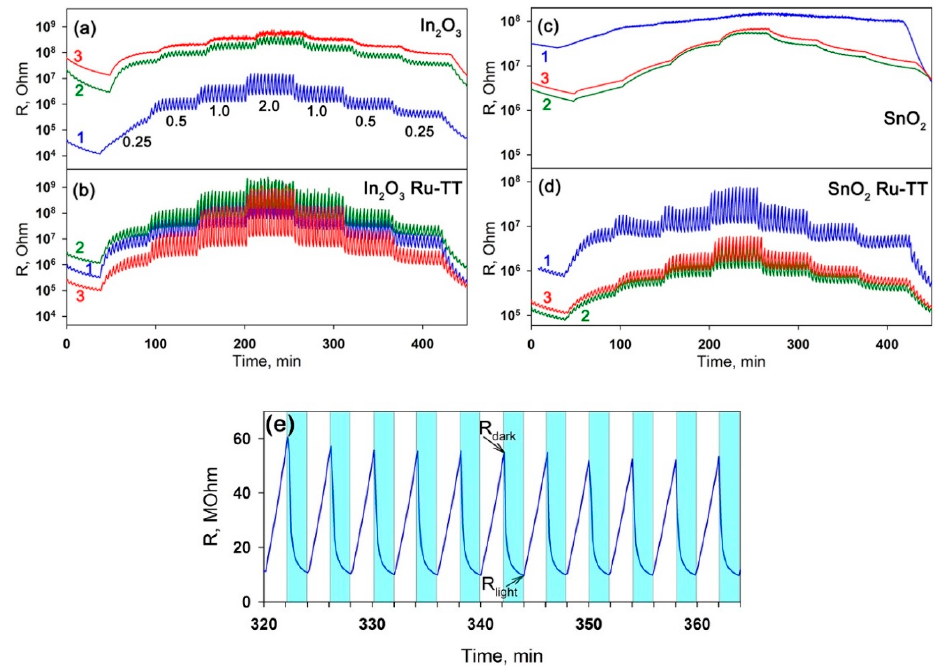
Figure 9. Room-temperature electrical resistances of ( a ) In 2 O 3 , ( b ) In 2 O 3 Ru-TT, ( c ) SnO 2 , and ( d ) SnO 2 Ru-TT samples under periodic illumination, depending on NO 2 content in the gas phase. (1): blue light ( λ max = 470 nm), (2): green light ( λ max = 535 nm), (3): red light ( λ max = 630 nm). The digits on Figure 9a show the sequence of changes in NO 2 concentration (ppm). ( e ) Room-temperature electrical resistance of the In 2 O 3 Ru-TT sample in the presence of the 0.5-ppm NO 2 concentration under periodic blue light ( λ max = 470 nm) illumination. The shaded areas correspond to the “light on” period.